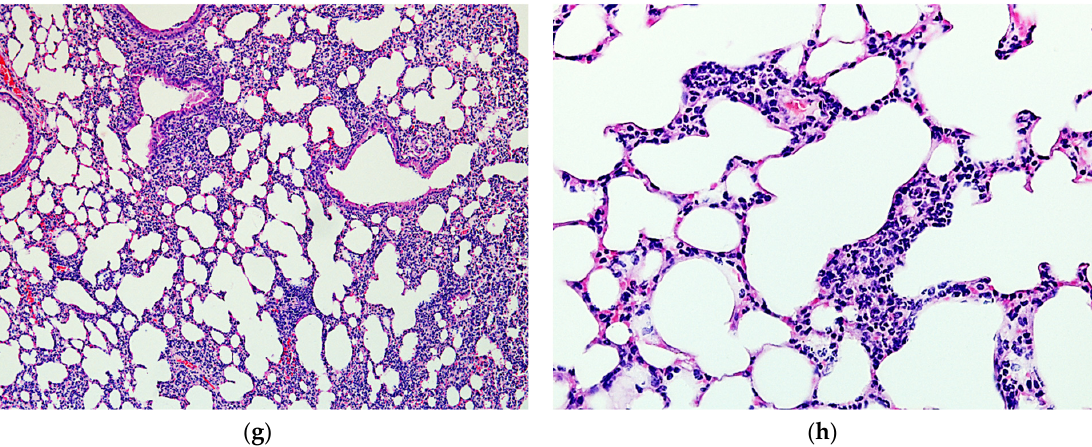
Figure 8. Lung sections. H&E staining: ( a , b ) Intact control; ( c , d ) LPS-control; ( e , f ) LPS + 5 mg/kg dexamethasone; ( g , h ) LPS + 30 mg/kg 9g . Magnification ×100 ( a , c , e , g ); magnification ×400 ( b , d , f , h ). To specifically elucidate immune cell infiltration, we used immunostaining for CD68 glycoprotein, which is a specific marker for monocytes and macrophages (Figure 9) [32]. In the lung tissue of intact animals, CD68 + cells were localized in the adventitia of the respiratory bronchioles. Further, individual immunopositive cells were found on the alveolar surface, in the interalveolar septa, and in the interstitium of the lungs. LPS administration led to a massive accumulation of CD68 + macrophages in the thickened walls and on the surface of alveoli, as well as among infiltrating cells. In contrast to LPS, for LPS + dexamethasone treatment, large CD68 + cells, i.e., macrophages, were rarely detected. In addition, single small CD68 + cells were located on the surface of alveolar walls. Treatment with 9g also decreased the immunoreactivity of the lung tissue, and the cellular composition of the inflammatory infiltrate was represented mainly by mononuclear cells and CD68 + macrophages, which were located mainly in the thickened interalveolar septa and less often on the surface of the alveoli.